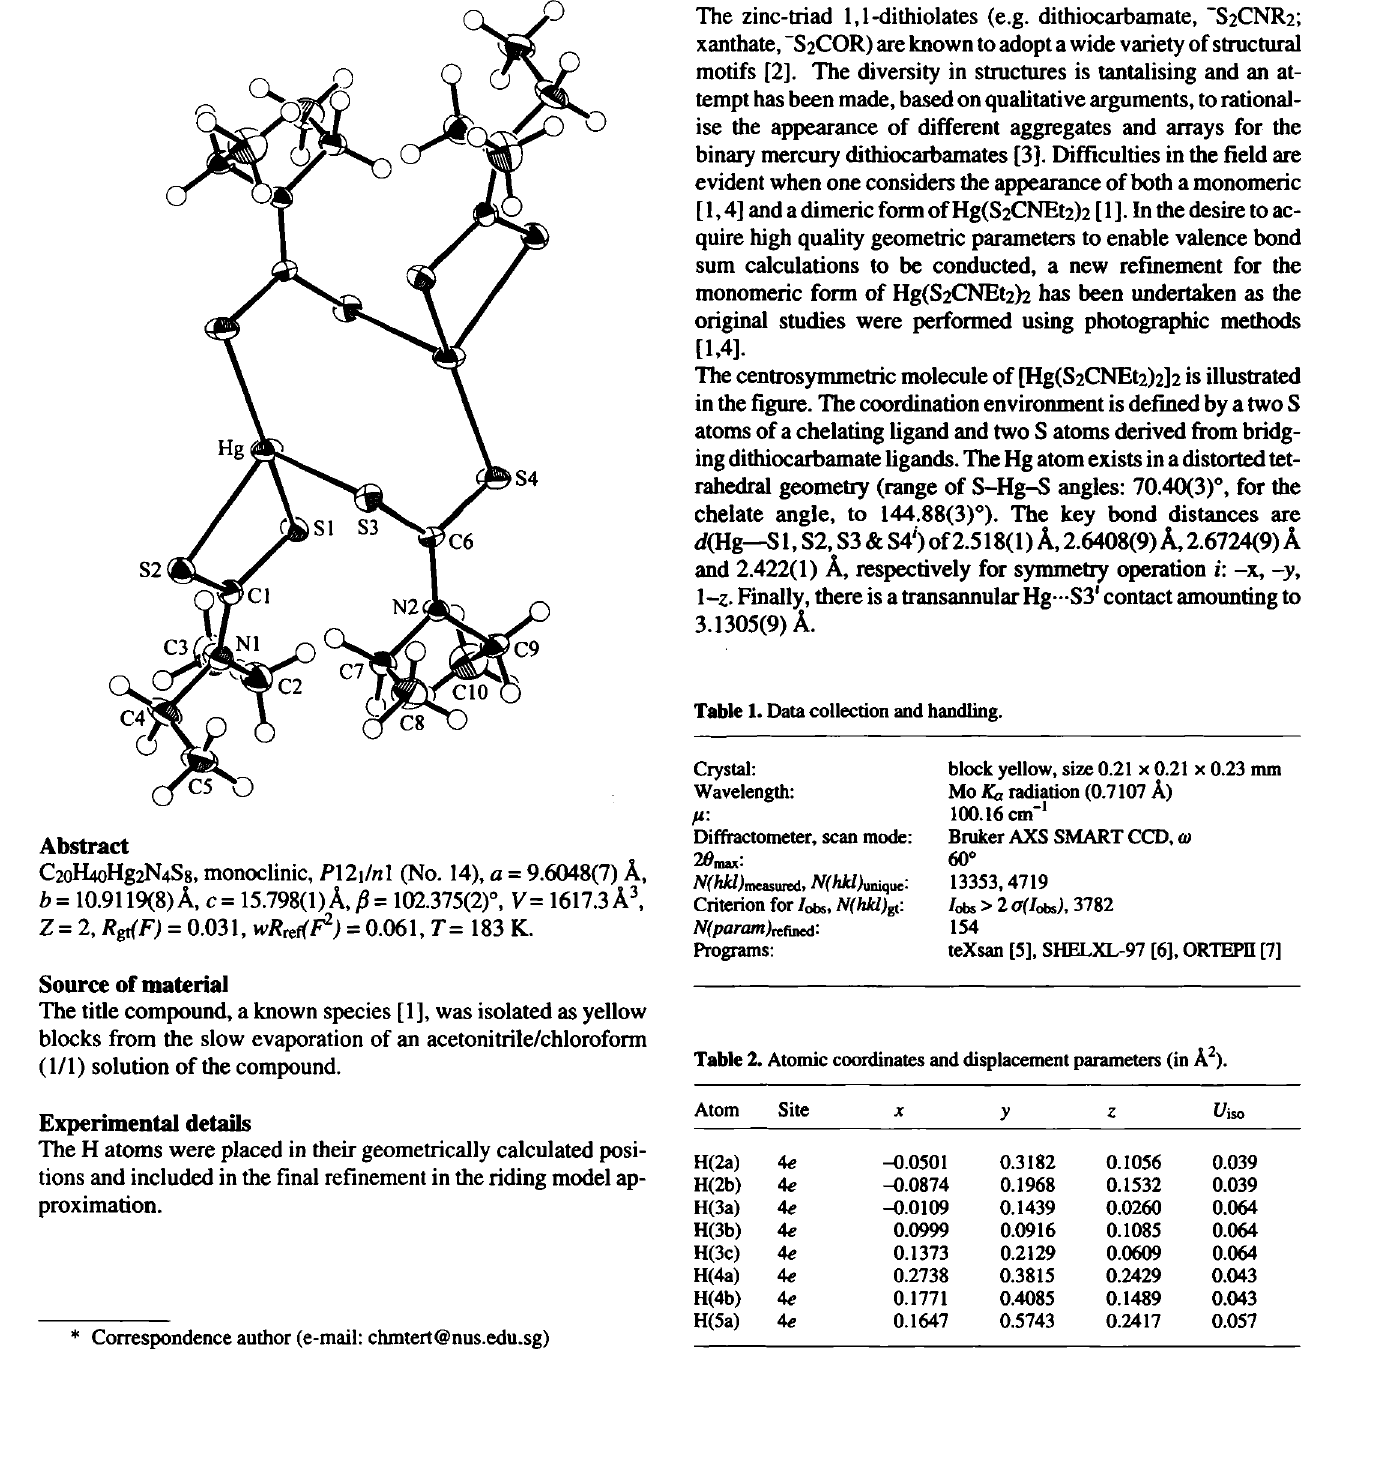
Table 2. Atomic coordinates and displacement parameters (in Â 2